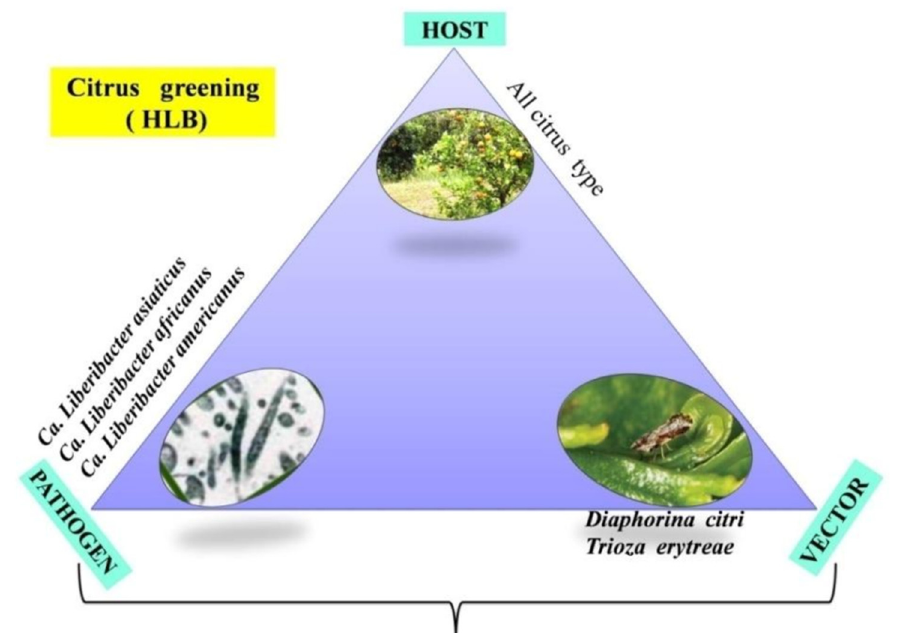
Figure 6. Triangular control management of HLB.